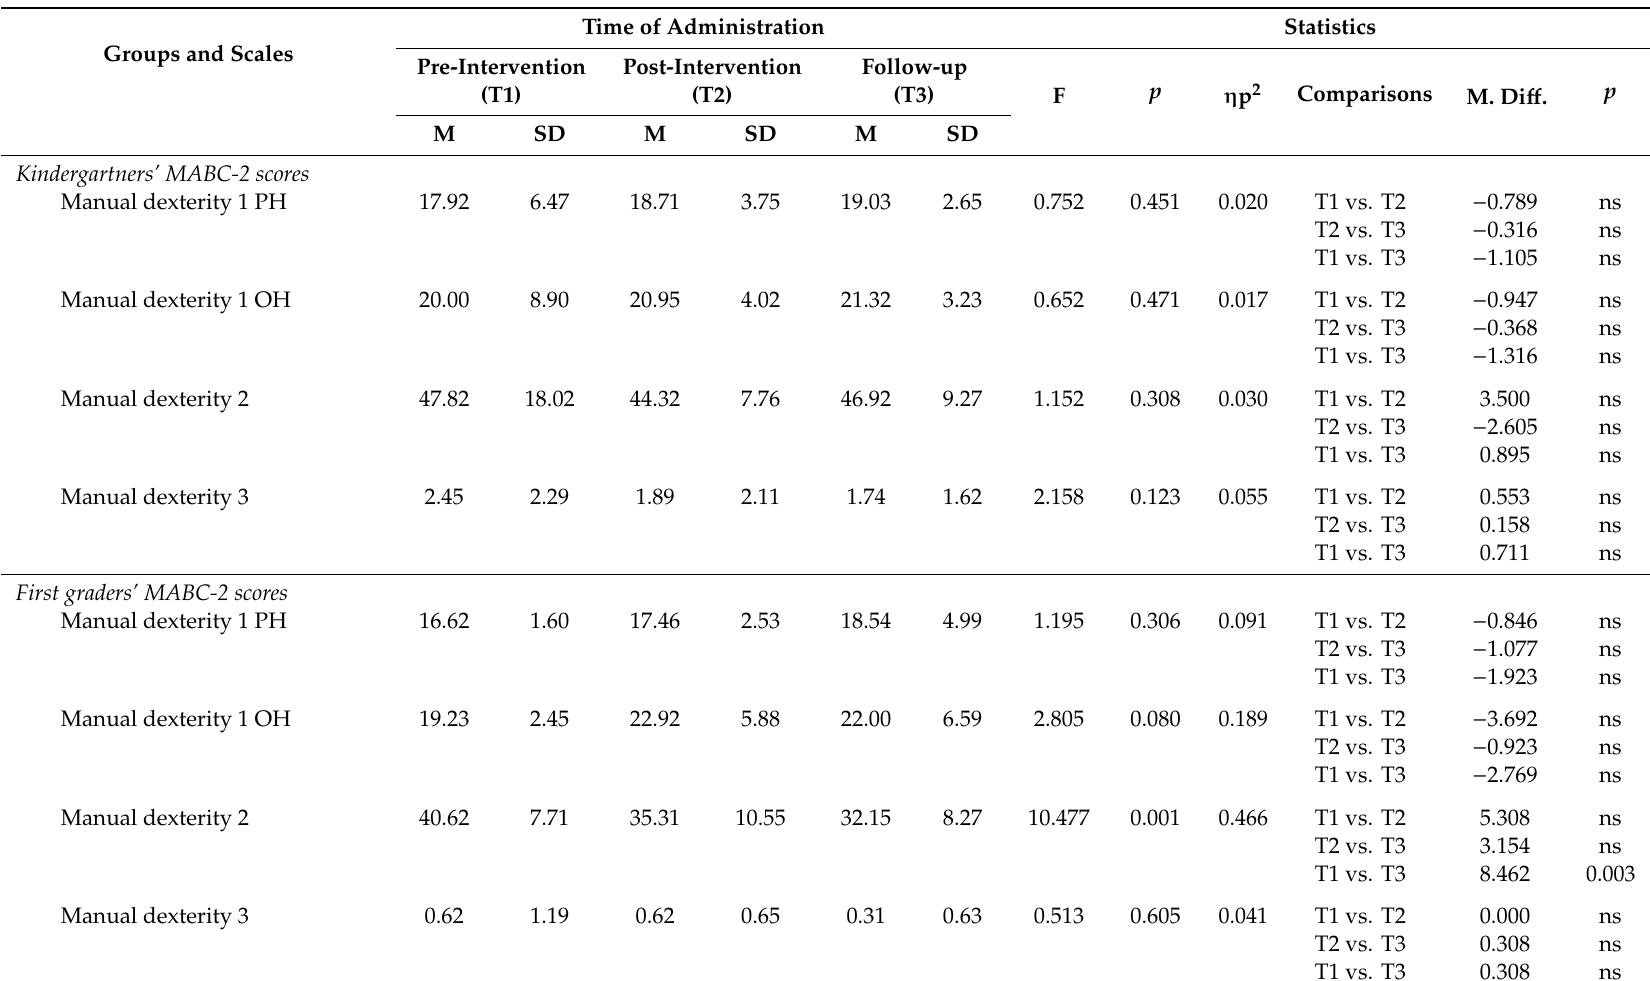
Table 5. Changes over time in kindergartners’ and first graders’ motor performances reported as raw scores at the manual dexterity tasks of the MABC-2 at T1, T2 and T3. Time of Administration Statistics Groups and Scales Pre-Intervention Post-Intervention (T1)